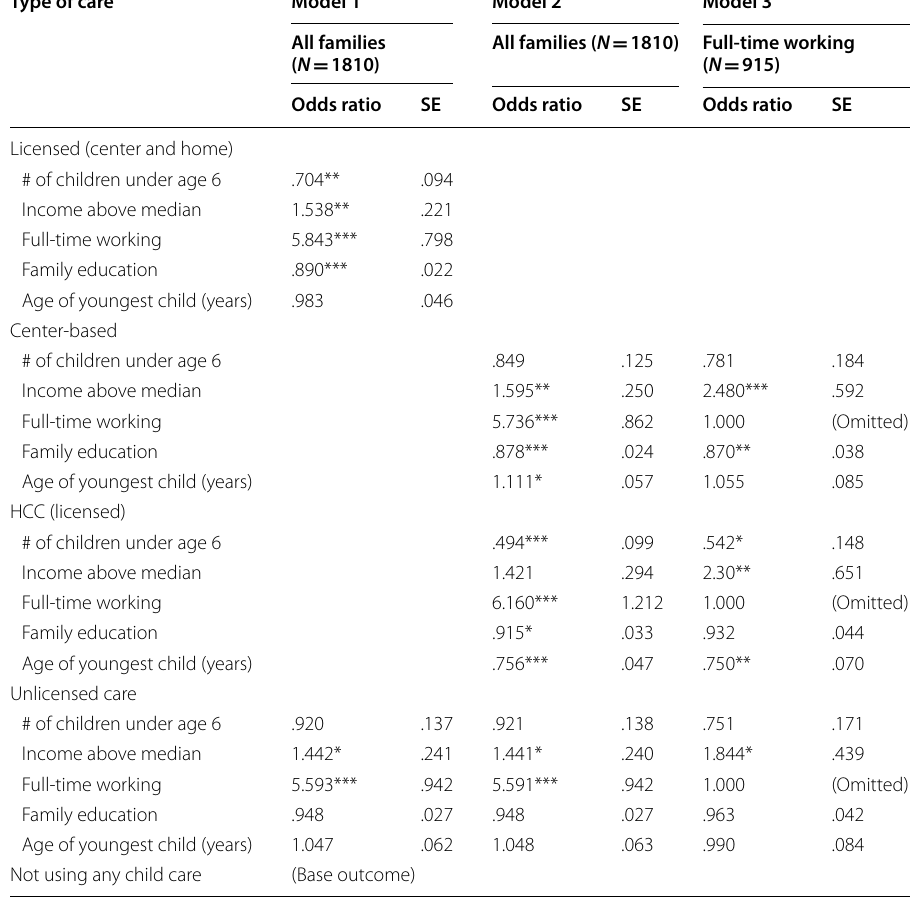
Table 1 Type of ECEC used by the youngest child in the